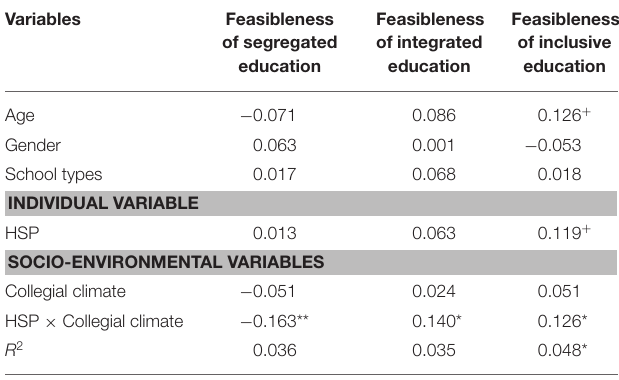
TABLE 2 | Regression analyses to predict feasibleness of segregated, integrated, and inclusive education. Variables